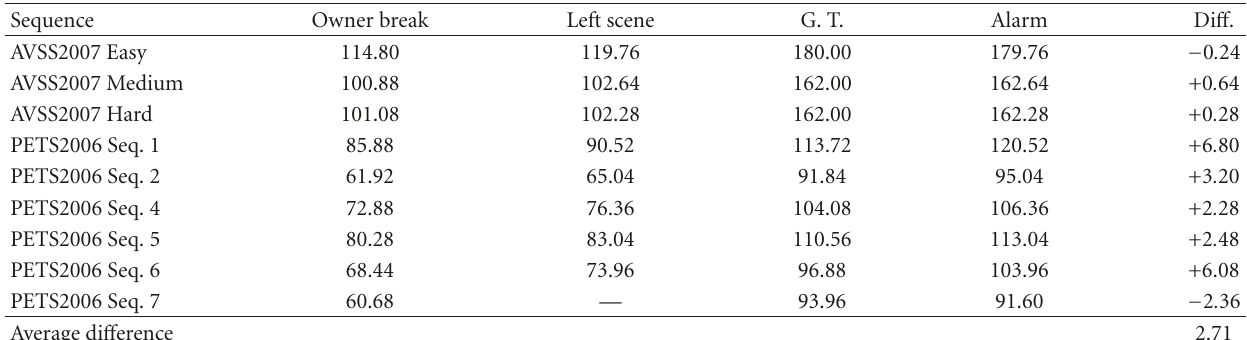
Table 1: Alarm time (second).